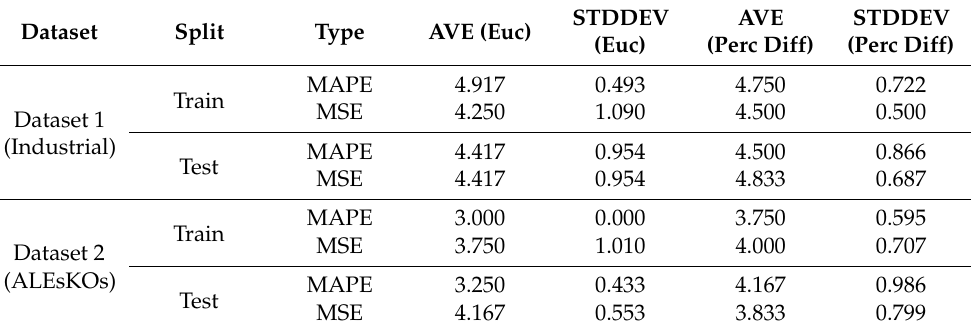
Table 1. The number of unique class labels applied to each of the discrete node layers (n = 7 for Dataset 1 and n = 6 for Dataset 2) where Dataset 1 has 7 unique classes and Dataset 2 has 6 unique classes. ConcsBN, Sampling, and FCLog10 preprocessing was used for all networks. The latent space for Dataset 1 consisted of 7 discrete nodes and 1 continuous node while the latent space for Dataset 2 consisted of 6 discrete nodes and 1 continuous node. The average and standard deviation are based on n = 12 replicate